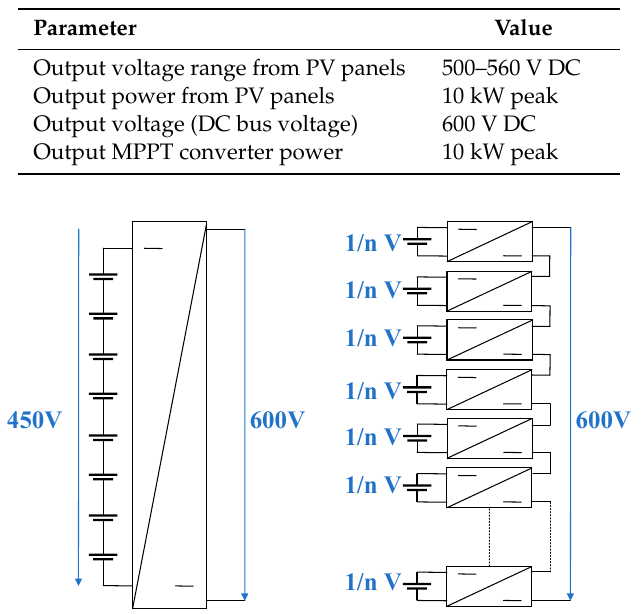
Figure 5. Block diagram of non-modular converter concept ( left ) and modular converter concept ( right